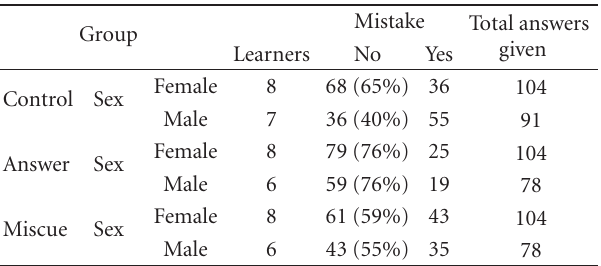
Table 3: Learner’s